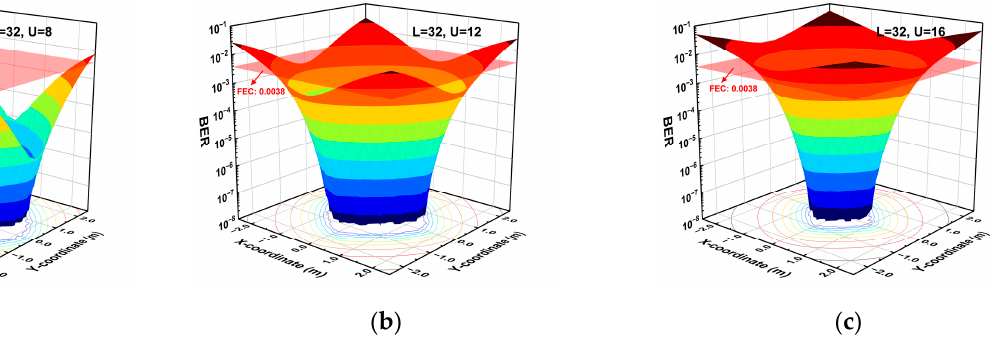
Figure 4. Surface diagram of BER estimated at all testing points when the user number is ( a ) 8 users, ( b ) 12 users, and ( c ) 16 users.